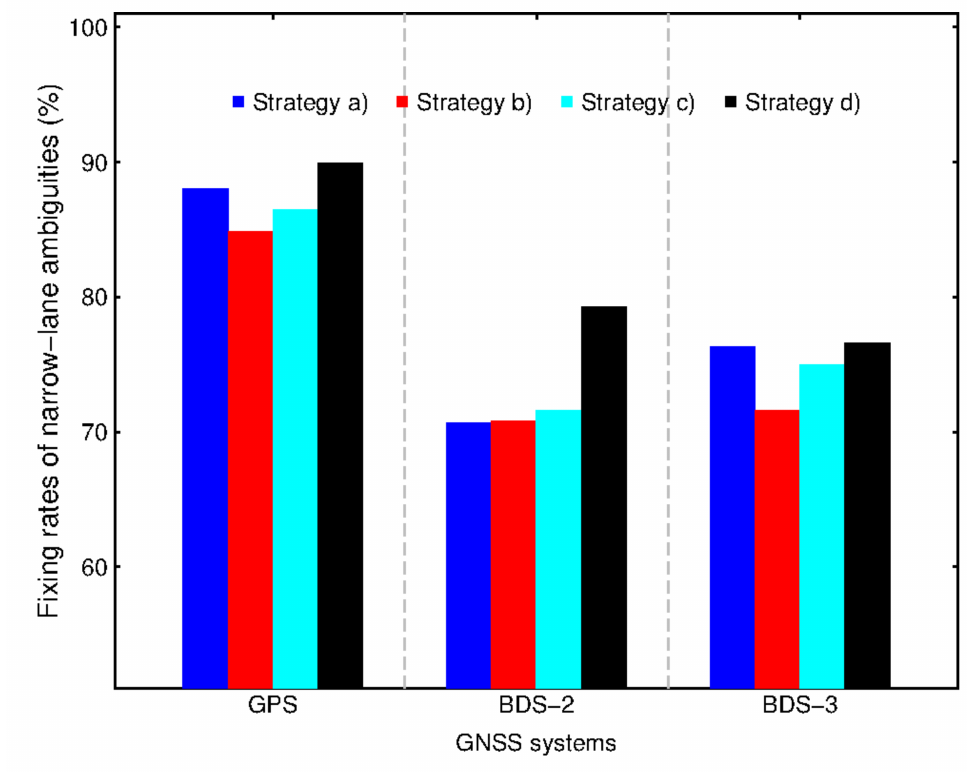
Figure 5. Narrow-lane ambiguity fixing rates (%) for daily kinematic solutions corresponding to four strategies on day 081 to 110,